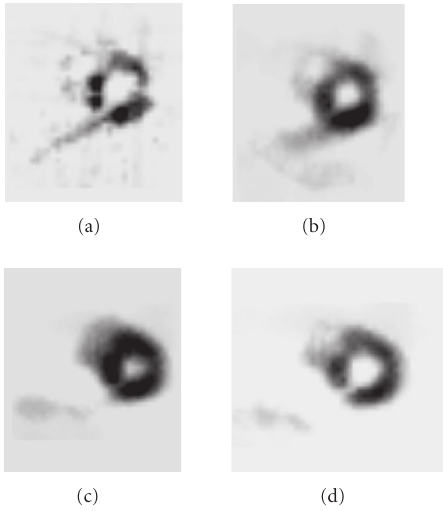
Figure 6: Normal mouse heart perfusion. Reconstruction with 3 iterations of FA-SART, ρ = 1 (a), 3 iterations of FA-SART, ρ = 0 . 8 (b), 3 iterations of SART (c), and 10 iterations of SART